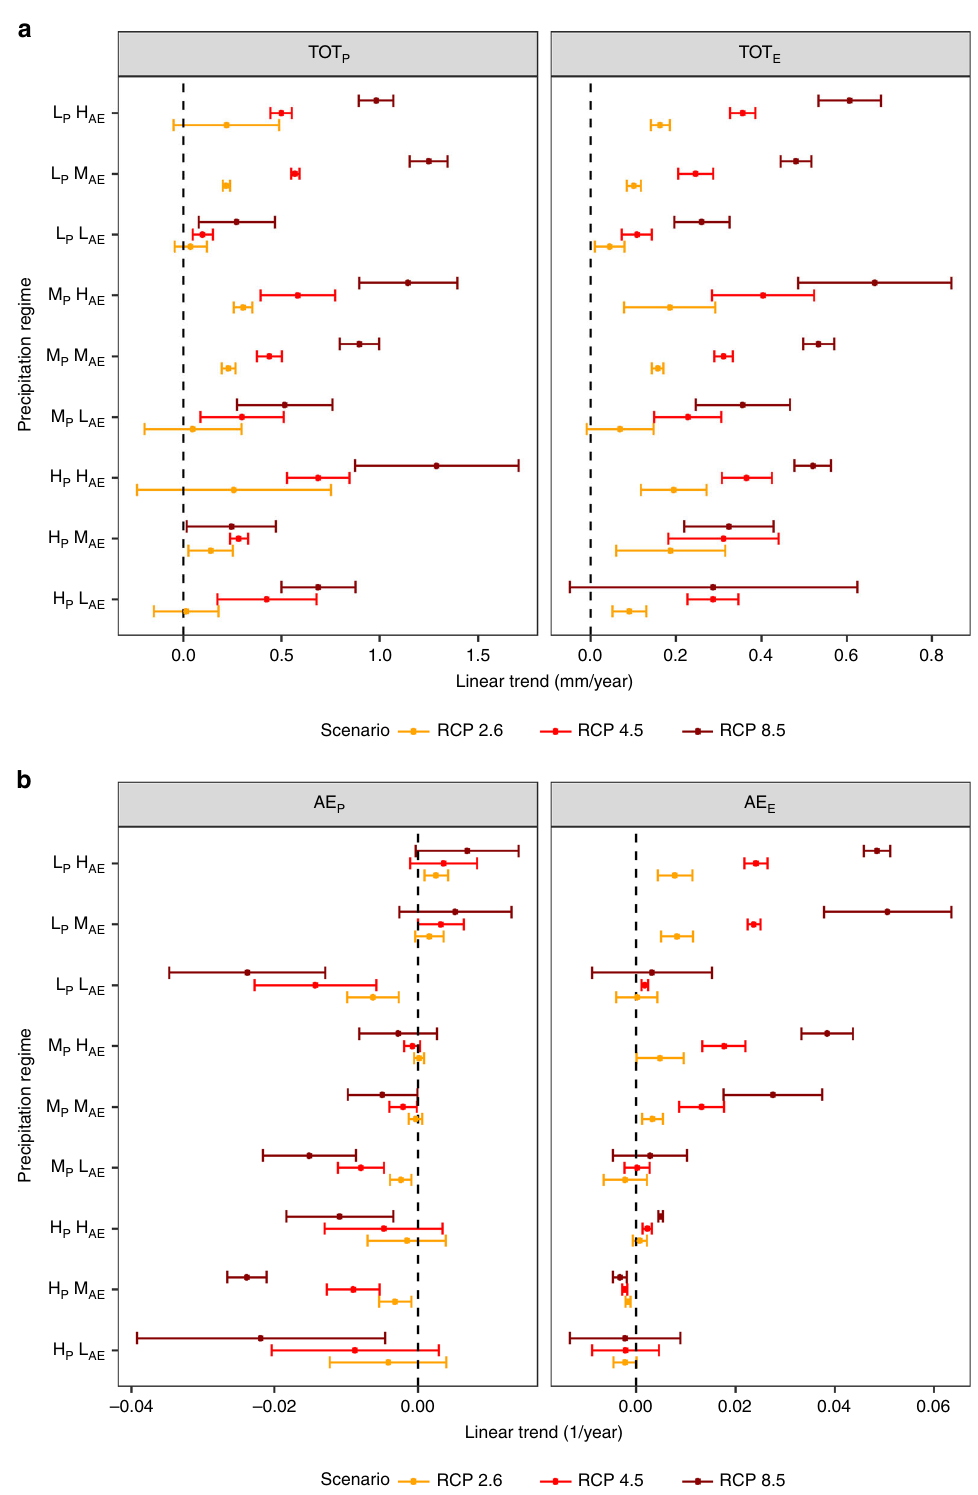
Fig. 2 Trends in precipitation and evaporation totals and seasonality. Theil-sen slopes of a total annual precipitation (TOT P ) and total annual evaporation (TOT E ) magnitudes, and b precipitation apportionment entropy (AE P ) and evaporation apportionment entropy AE E . The error bars surrounding the point estimates represent the 95% con fi dence interval of the CMIP5 multimodel ensemble. H, M, and L represent high moderate and low values,